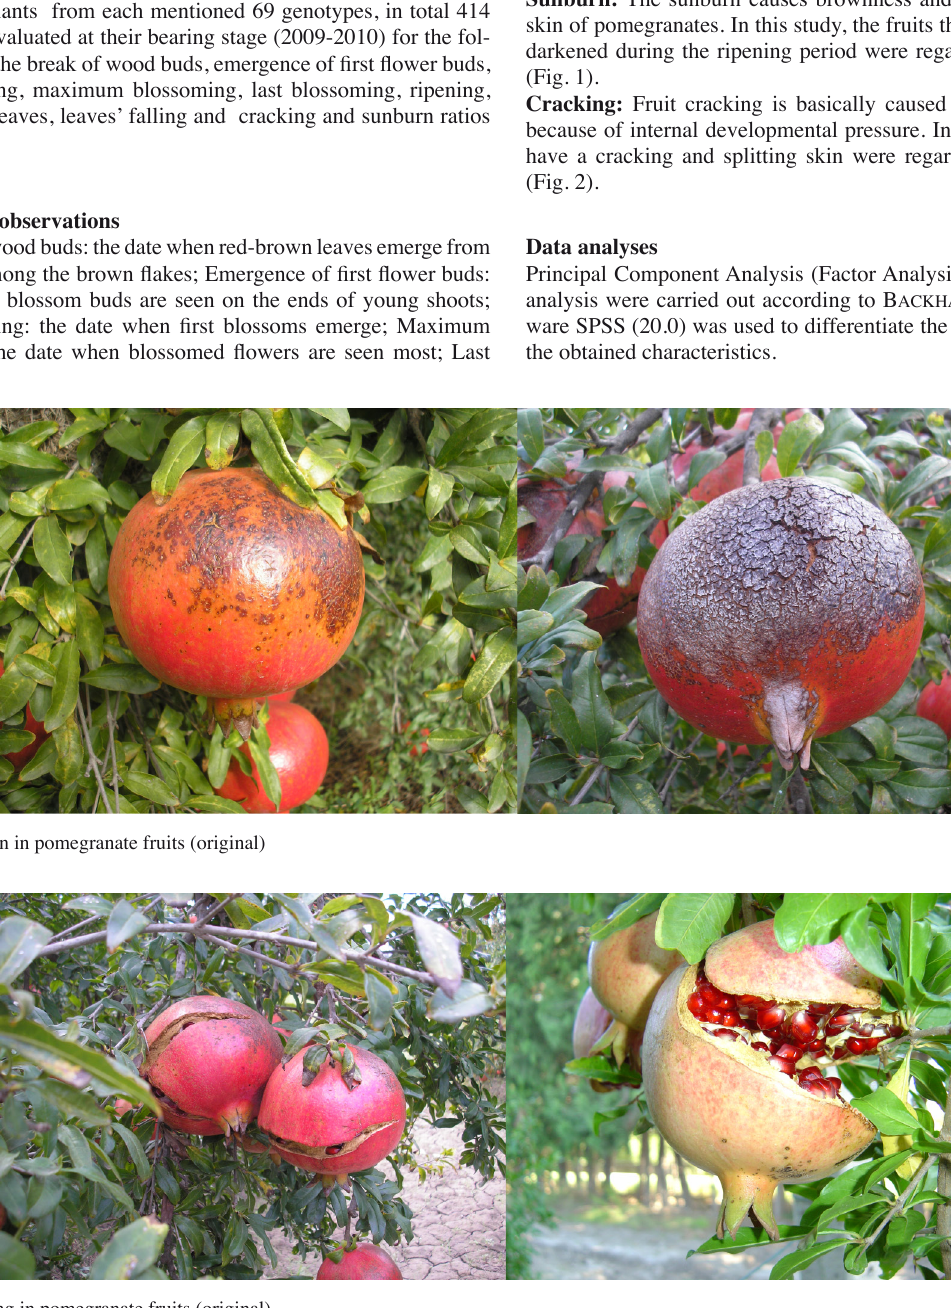
Fig. 2: Cracking in pomegranate fruits (original)